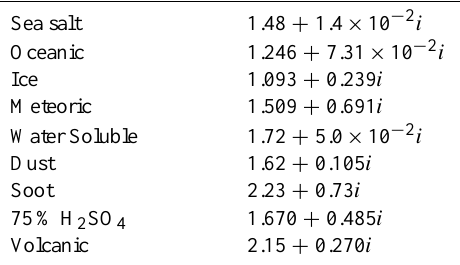
Fig. 12. There we can see that the relative difference of Q ext is maximum for radii of the order of 10 µm and remains large for radii up to 20 µm. For small radii, the relative difference grows steadily with the radius, but it is less than 5 % up to a radius of ∼ 2 µm. Light fogs with small particles are thus less